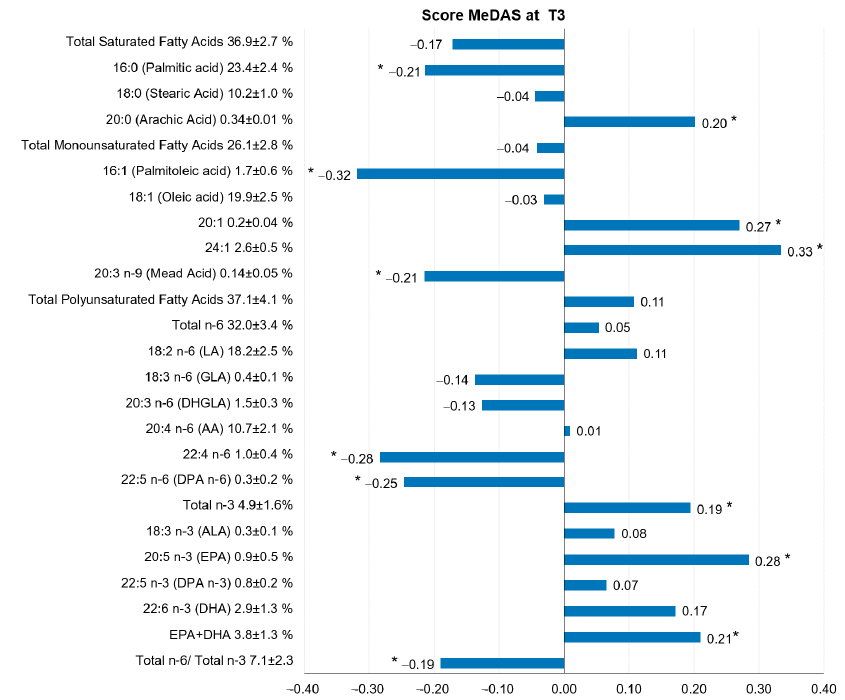
Figure 2. Correlations between the blood fatty acids profile and dietary Mediterranean-ness (MeDAS score) after three months of nutritional intervention ( n = 120). MeDAS score: Mediterranean Diet Adherence Screener score; LA: linoleic acid; GLA: γ -linolenic acid; DHGLA: diomo- γ -linolenic acid; AA: arachidonic acid; DPA: docosapentaenoic acid; ALA: α - linolenic acid; EPA: eicosapentaenoic acid; DHA: docosahexaenoic acid. * p -value <